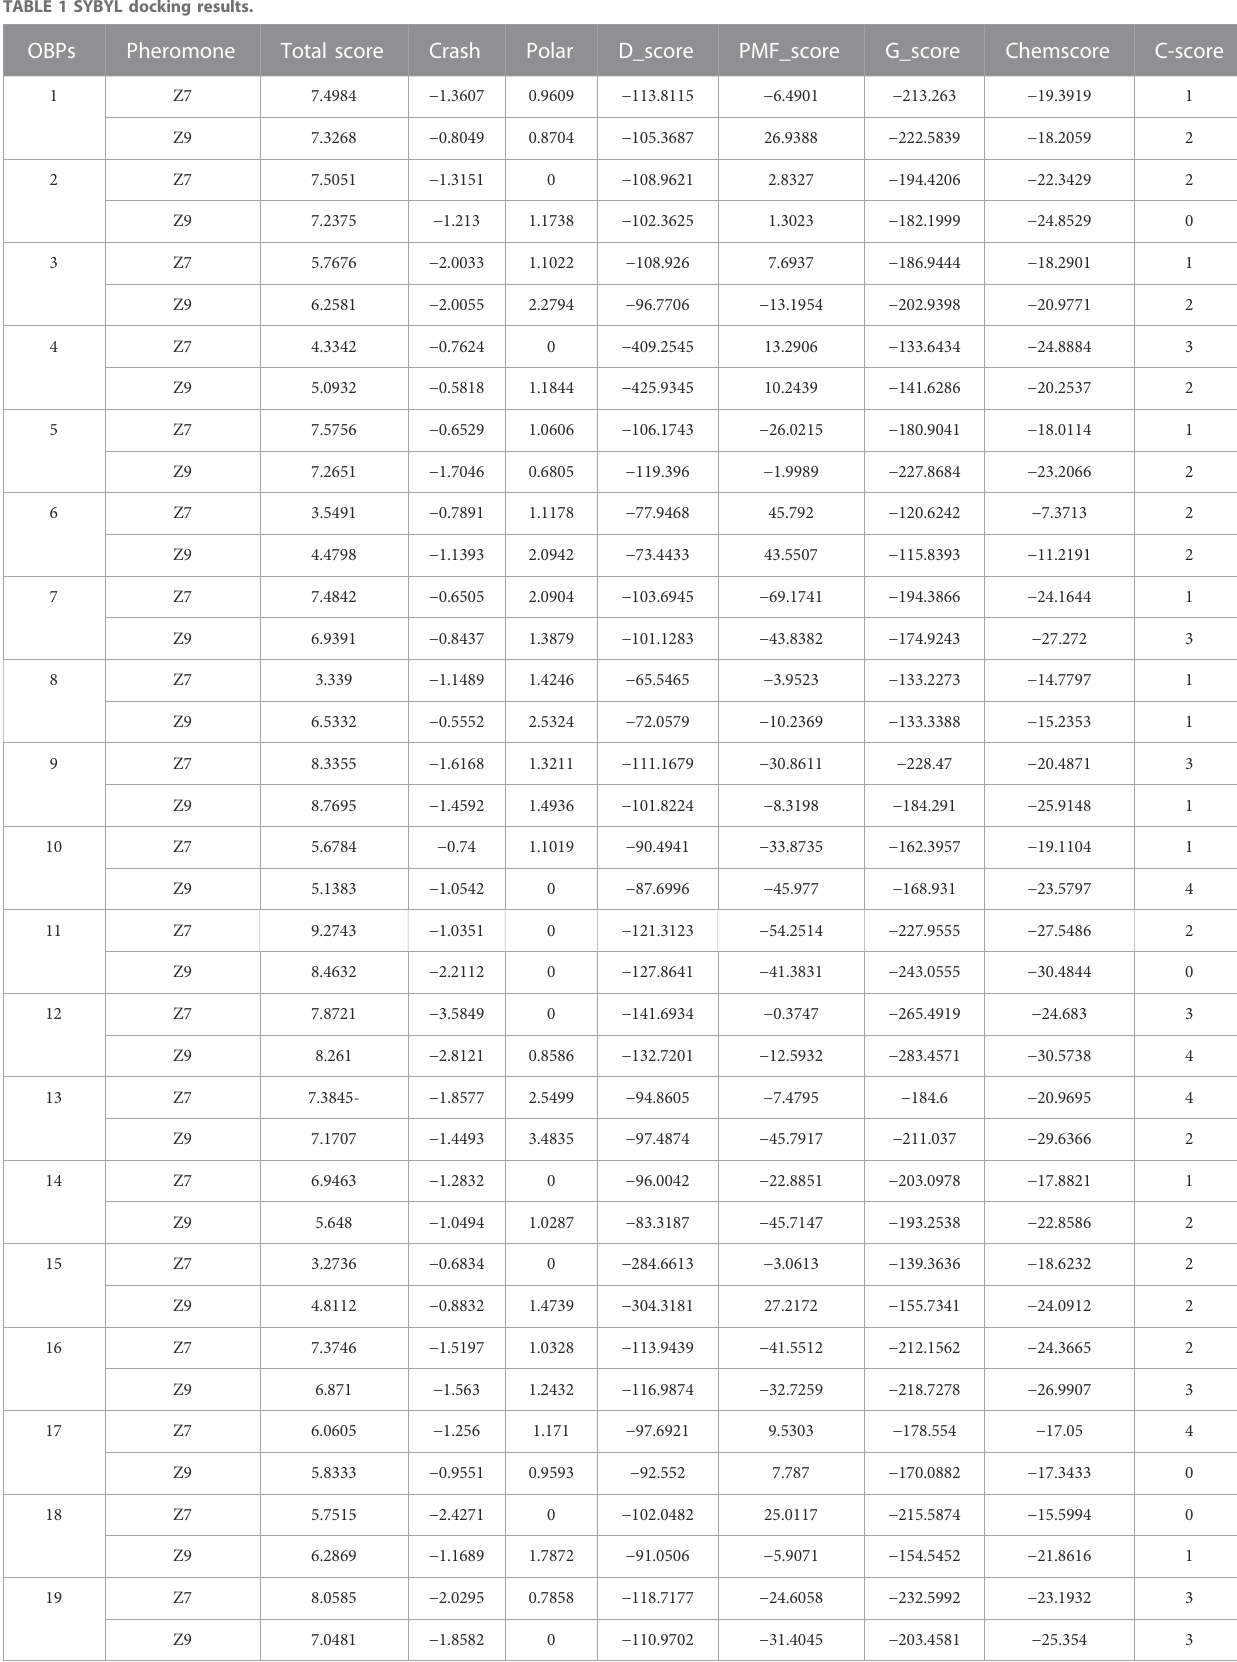
TABLE 1 SYBYL docking